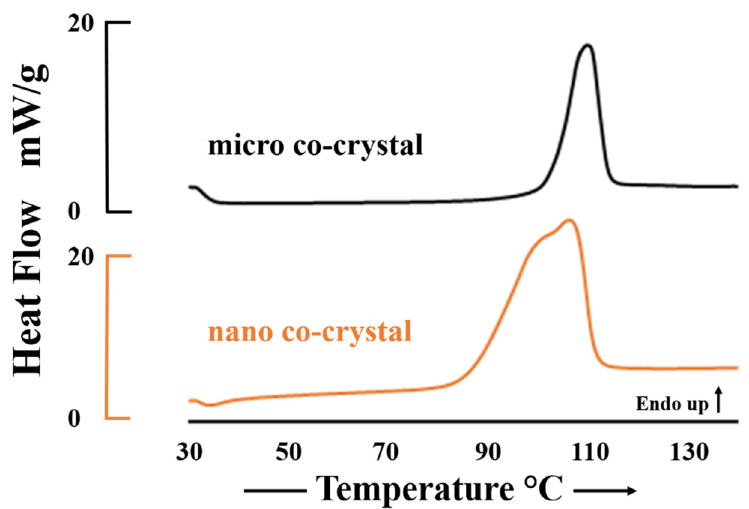
Figure 3. DSC thermograms depicting the melting endotherm for the micro (black) and nano co-crystal (orange).